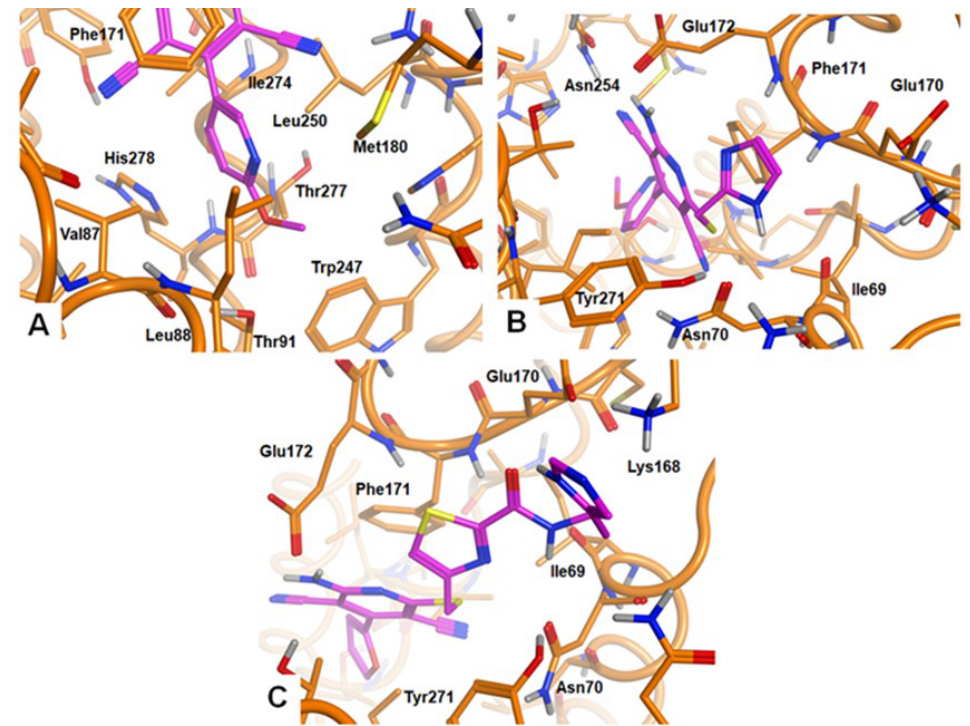
Figure 4. ( A , B ) Detailed view of the binding mode of compound 9 within the hA 1 AR cavity. ( A ) Detail of the interaction of the 4-heteroaryl substituent with the receptor residues in proximity. ( B ) Top view of the docking pose of 9 within the hA 1 AR cavity, with indication of the receptor residues in proximity of the 2-substituent. ( C ) Top view of the docking pose of derivative 17 within the hA 1 AR cavity, with indication of the receptor residues in proximity of the 6-side-chain.